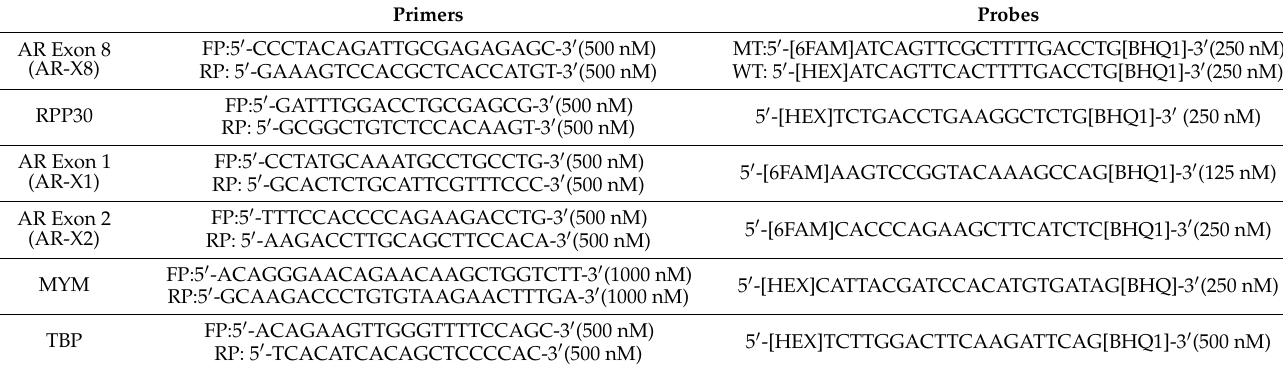
Table 1. Primers and probes with working concentrations in